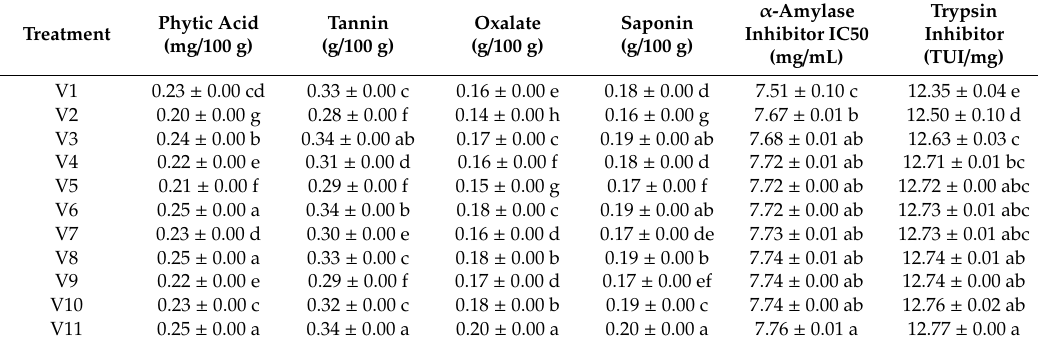
Table 3. Antinutrient composition of tomato fruits cv. Brillante F1 treated with di ff erent MaEs. Data are means ±